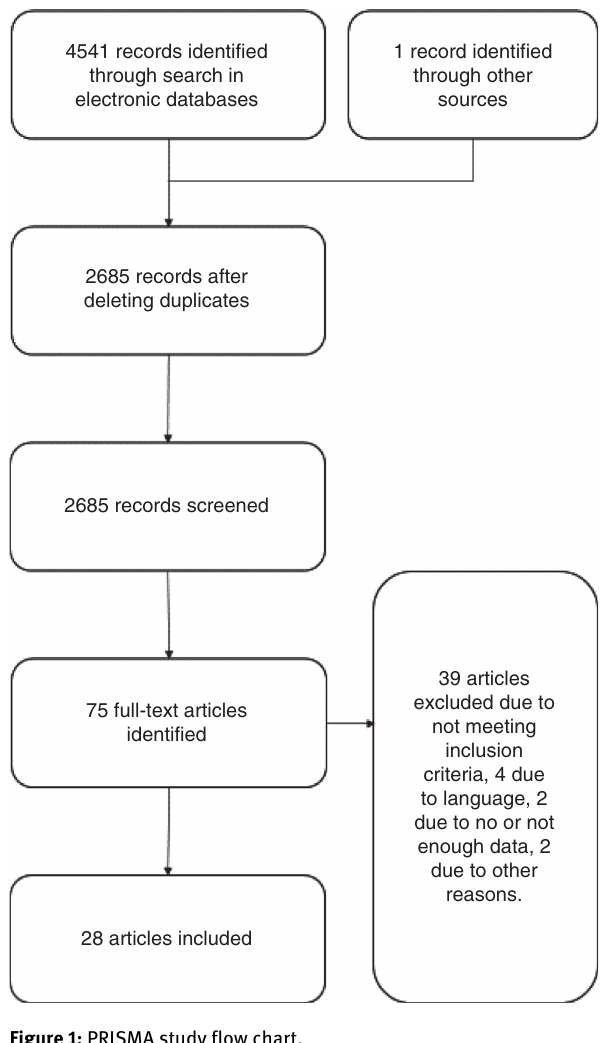
Figure 1: PRISMA study flow chart.